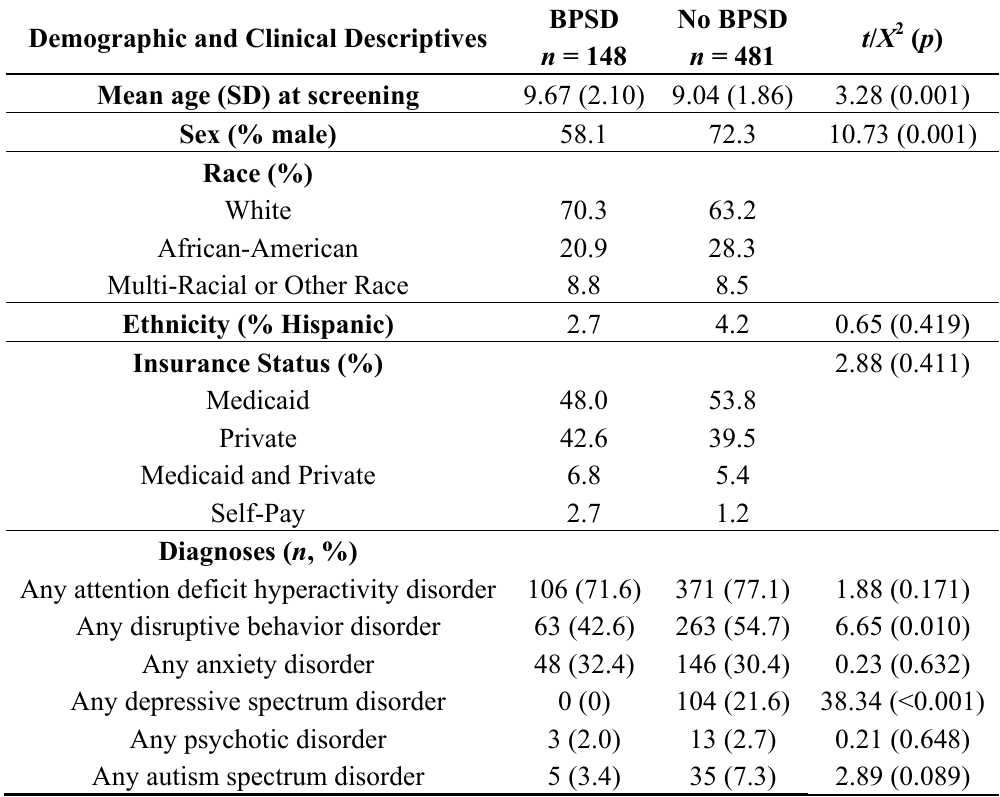
Table 1. Longitudinal Assessment of Manic Symptoms (LAMS) sample description, separately for children with and without bipolar spectrum disorders